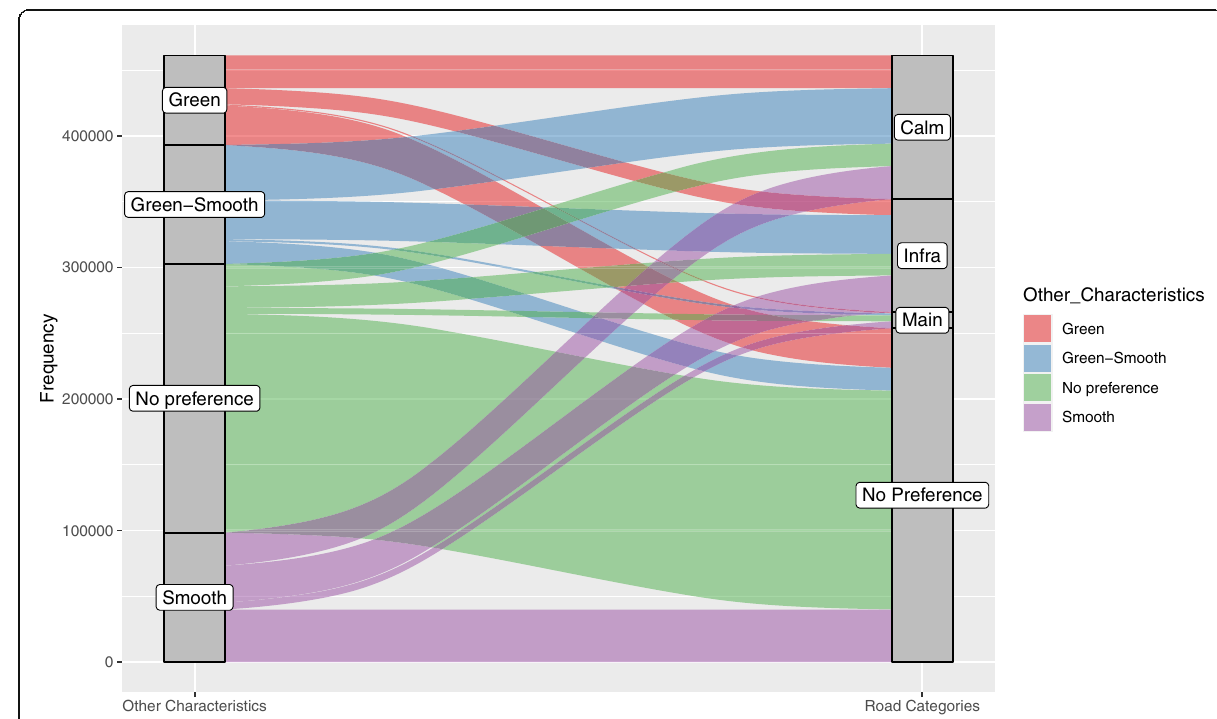
Fig. 11 Interrelations between preferences for other characteristics (left column) and road categories (right column). Other characteristics: prefer green pathways (Green), avoid bad surfaces (Smooth), prefer green pathways and avoid bad surfaces (Green-Smooth); Road preferences: prefer calm residential roads (Calm), avoid main roads without cycle infrastructure (Infra), prefer main roads (Main); simple and strong preference summed